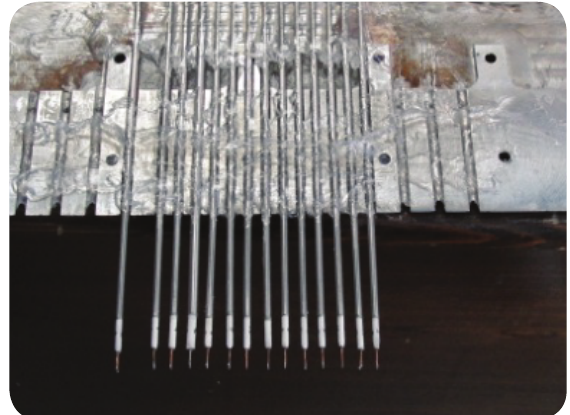
Figure 3. Rake of hot wire